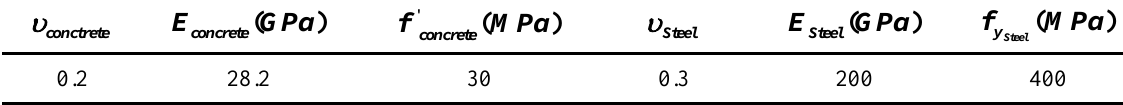
Fig. 2. Moment- axial force interaction diagram for concrete lining segments: Negative value for the axial force represents tension and positive value means compression. Table 3. Material properties of concrete lining